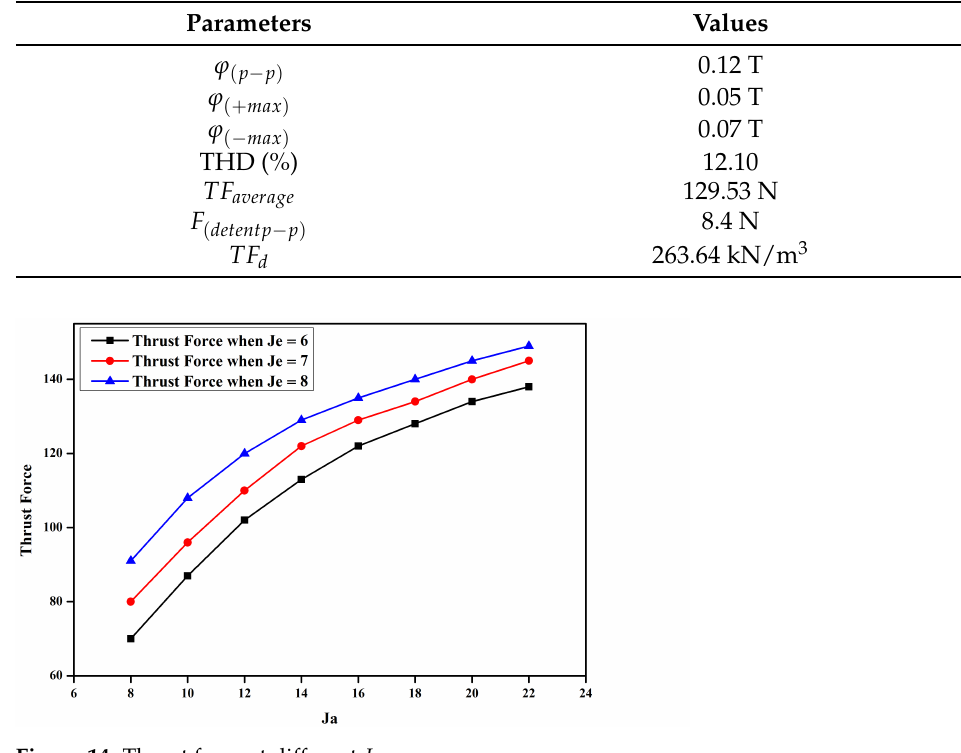
Figure 14. Thrust force at different J a .